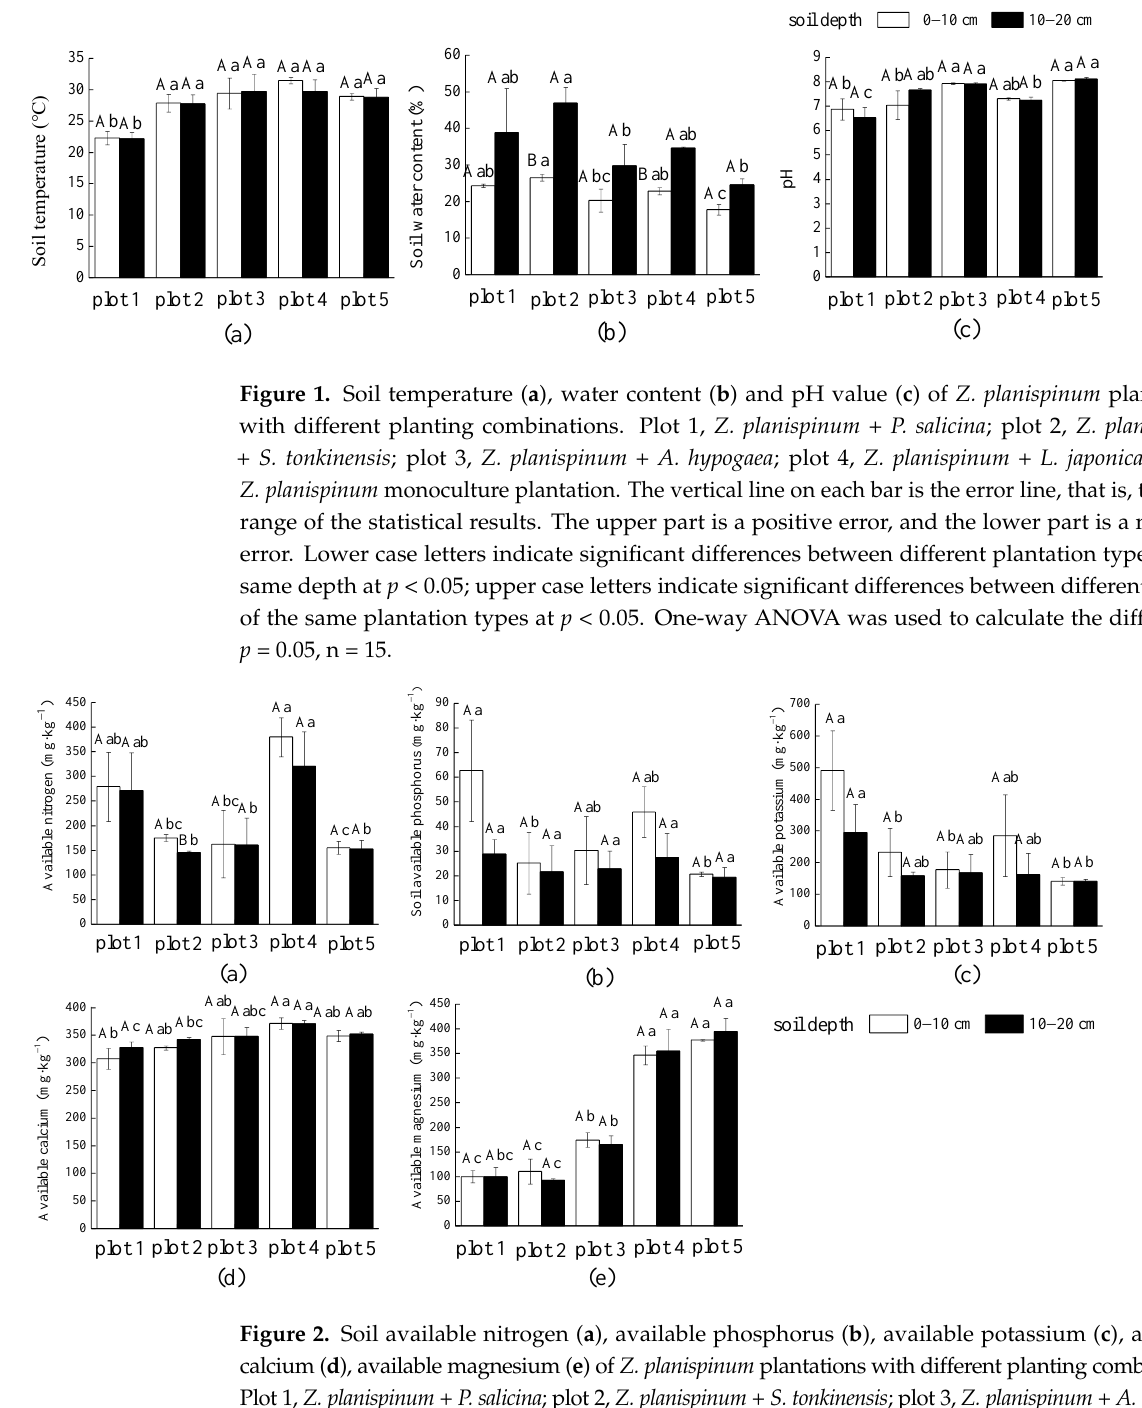
was no significant difference between the rest of the plots. SWC values in both soil layers showed that plot 2 > plot 1 > plot 4 > plot 3 > plot 5, and the values were significantly higher in plot 2 than in plots 3 and 5 and increased with the deepening of the soil layer, indicating that the allocation of P. salicina could improve SWC. The pH values in the 0 – 10 cm soil layer were significantly higher in plots 3 and 5 than in plots 1 and 2 and signifi- planting pattern on available nutrients was greater than that of total nutrients, especially cantly lower in plot 1 in the 10 – 20 cm soil layer, indicating that the combination with P. on available Ca and available Mg. The combination with P. salicina and L. japonica was salicina had a certain effect on pH improvement (Figure 1). beneficial to the accumulation of available N, available P, and available K (Figure 2).